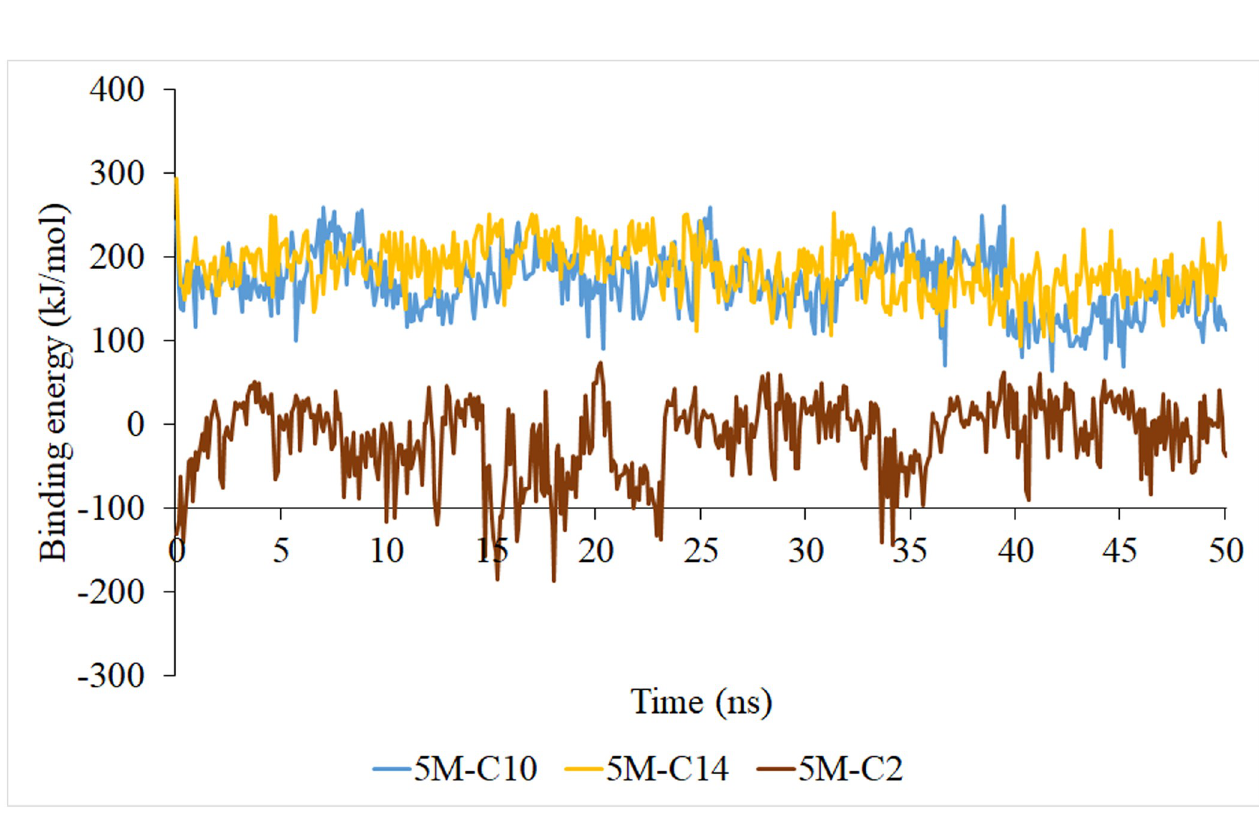
Fig 9. Binding energy of 5M-substrate